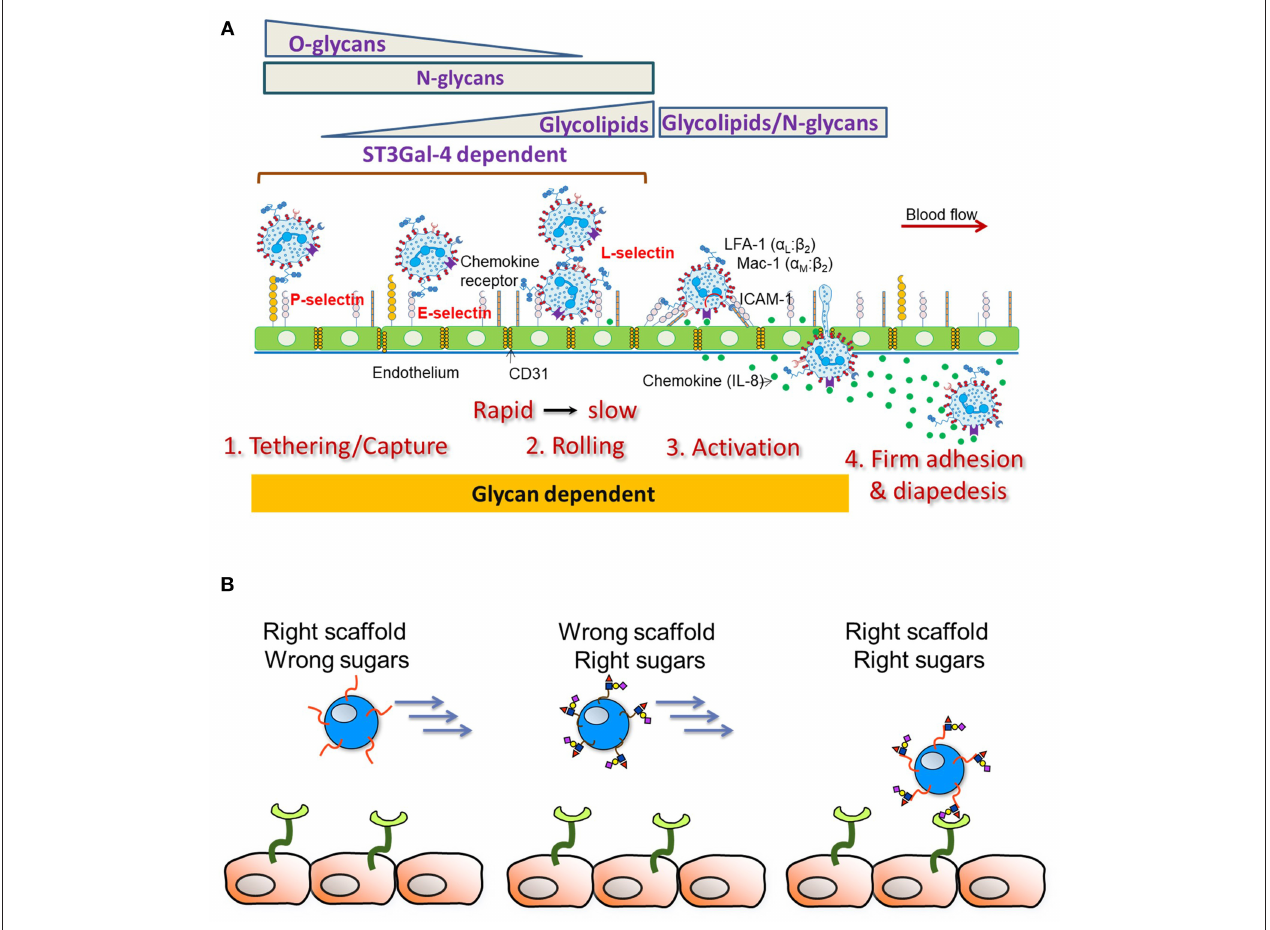
FIGURE 3 | Leukocyte-endothelial cell adhesion cascade. (A) Schematic depicts results from studies using human cells. The sialyltransferase ST3GaI4 is indispensable for all aspects of leukocyte adhesion. O-glycans are important for leukocyte capture from flow along with N-glycans. N-glycans largely control leukocyte rolling velocity with glycolipids also contributing to the transition to firm arrest. Besides cell adhesion, emerging evidence points to a role for glycans in also regulating cell activation and the transition to firm arrest. (B) Endowing heterologous cell types (like Mesenchymal Stem Cells, MSCs) with selectin scaffold proteins (“right scaffold”) along with enzymes facilitating the construction of sialofucosylated glycans (“right sugars”) can enable stem cell capture and rolling on the inflamed